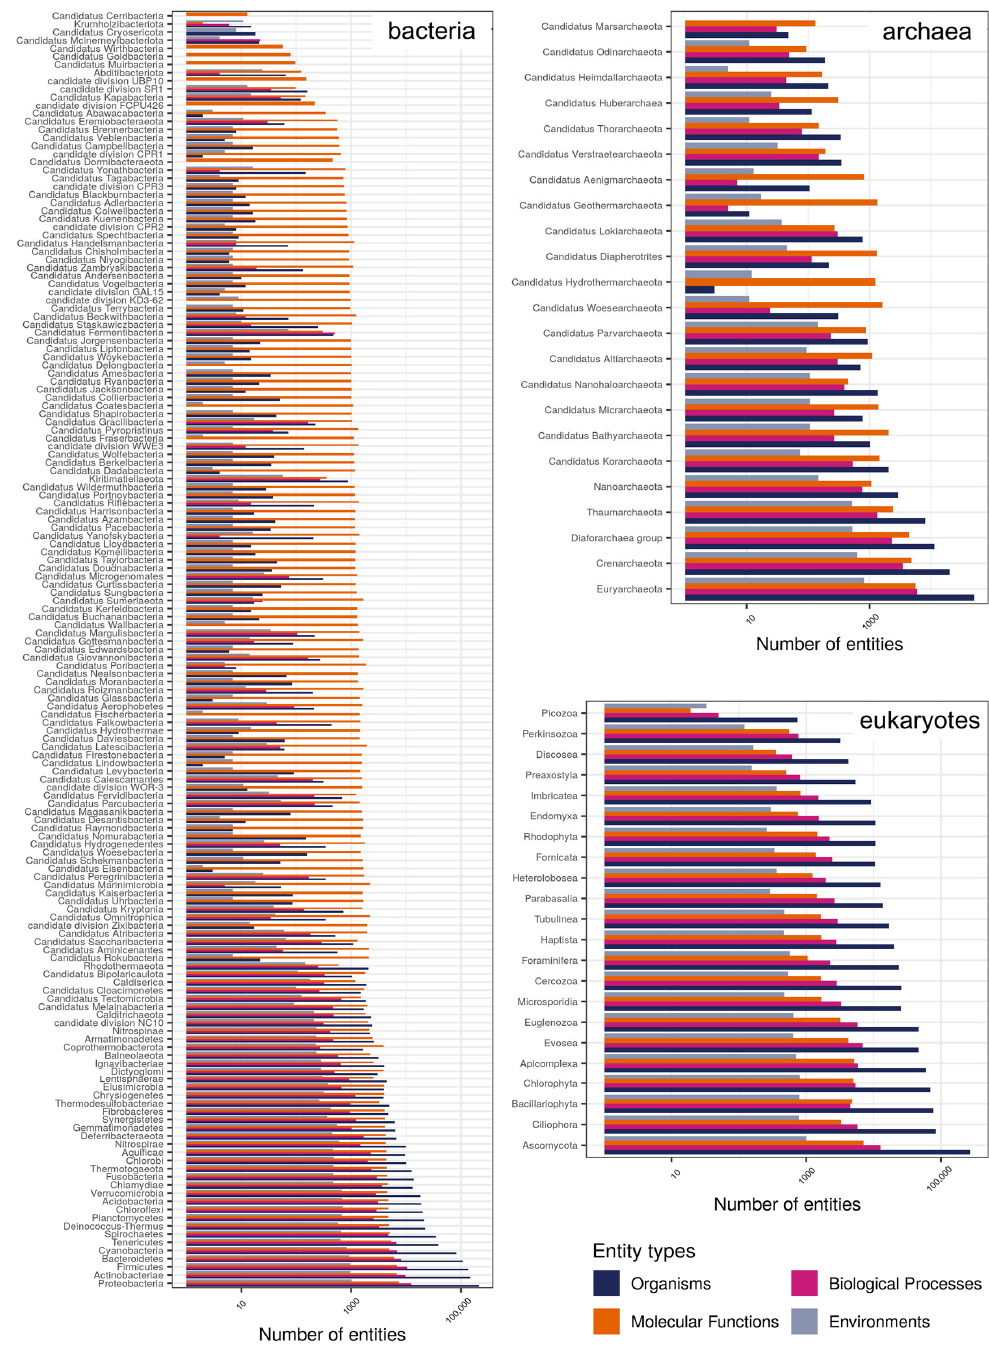
Figure 5. Summary of all the unique entities per phylum for each of the four entity types (in log10 scale) that appear in PREGO. Phyla are grouped based on their superkingdom (in log10 scale). Only phyla for which associations are available in the PREGO platform are mentioned.